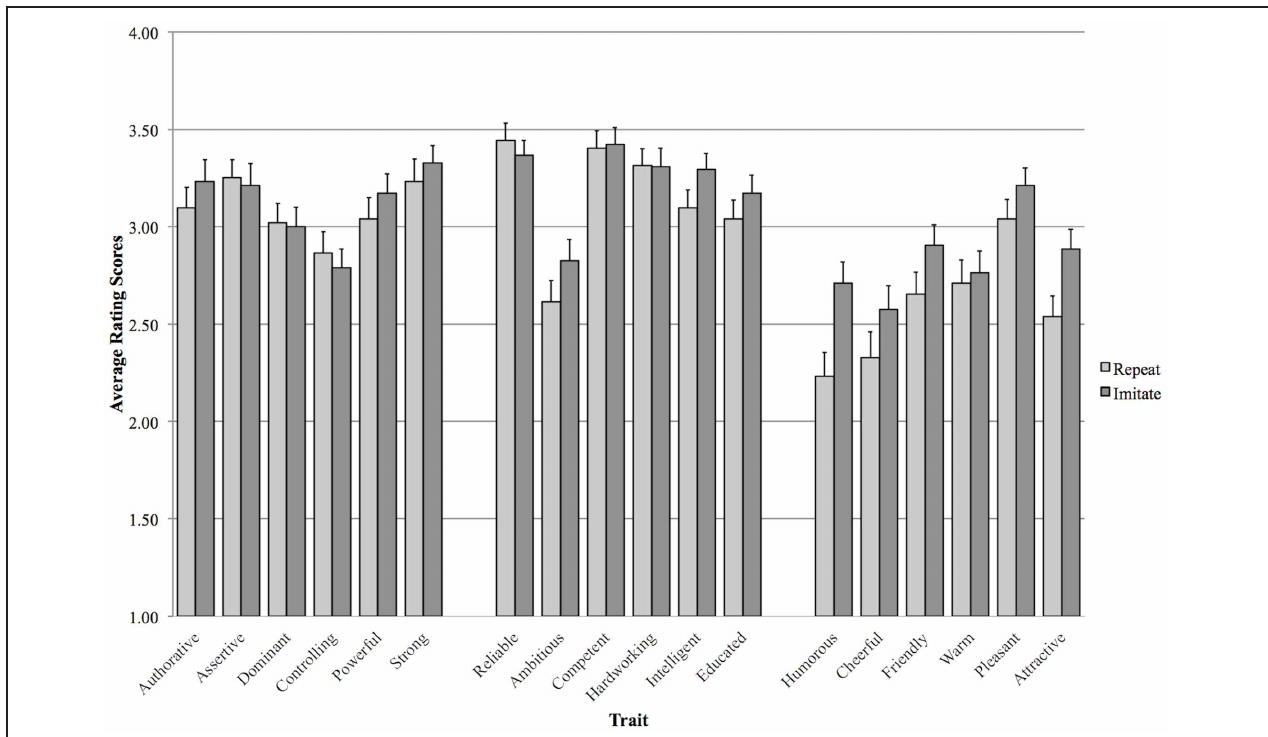
FIGURE 2 | Average rating scores for Task: Repeat and Imitate, for all 18 traits (error bars represent one standard error of the mean) for both GE speakers.